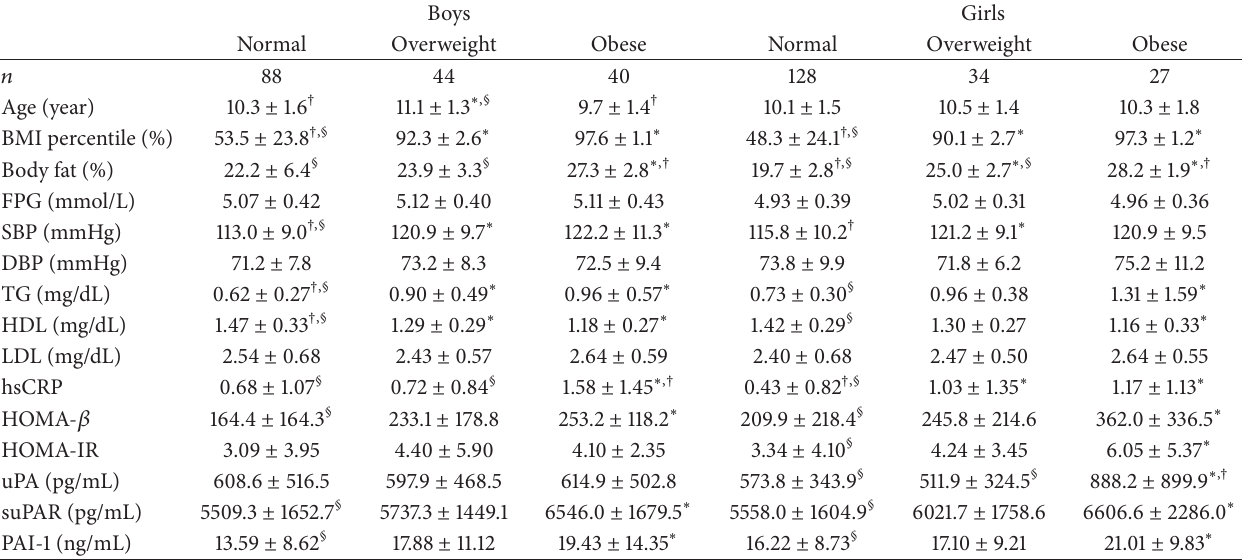
Table 2: General characteristics of components of metabolic syndrome, insulin secretion, and resistance in boys and girls. Boys Girls Normal Overweight Obese Normal Overweight Obese 𝑛 88 44 40 128 34